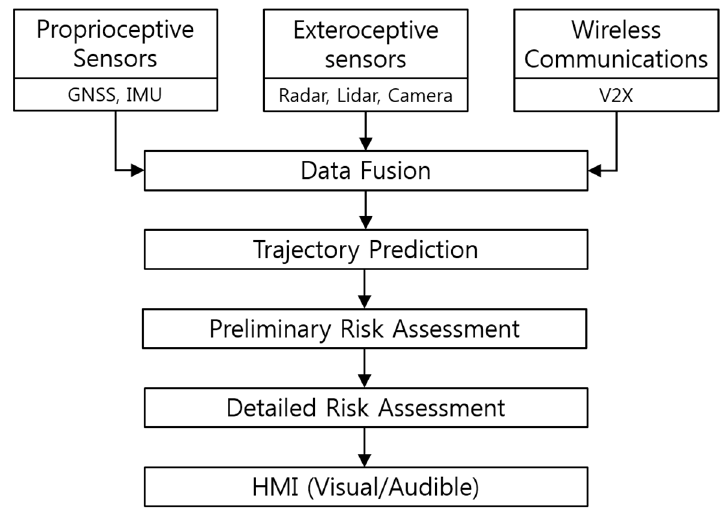
Figure 2. Block diagram summarizing the steps for collision warning generation.